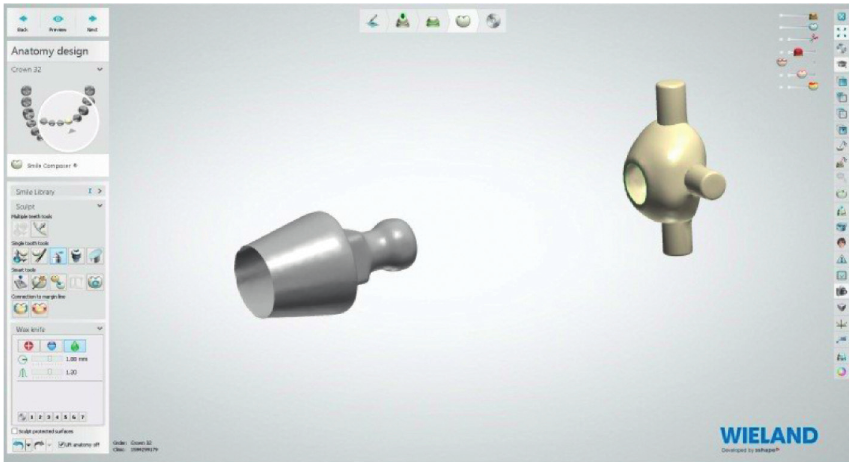
Figure 3: PEEK cap and ball abutment